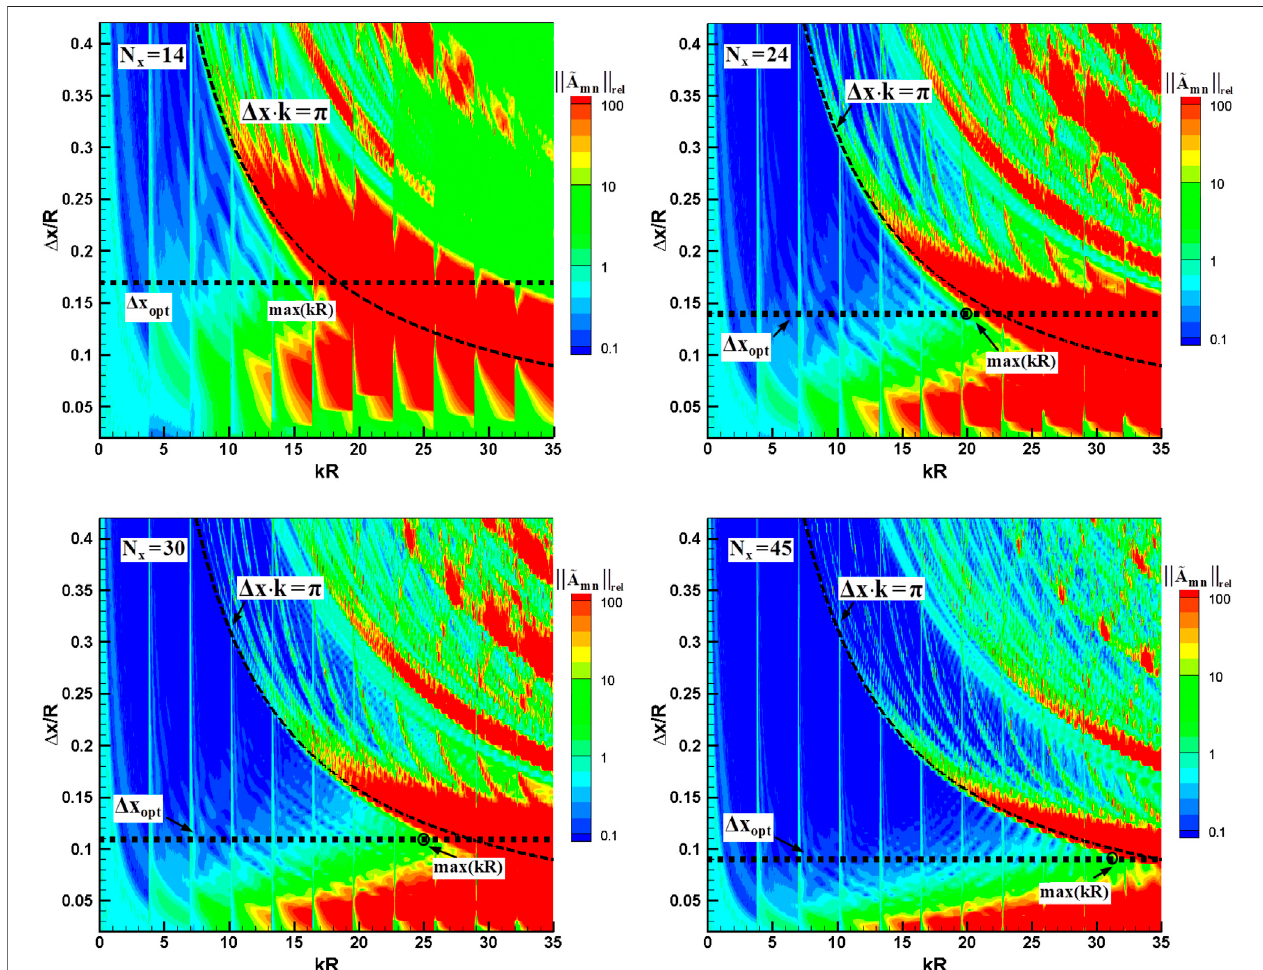
FIGURE 3 | Relative accuracy of the four axial arrays.